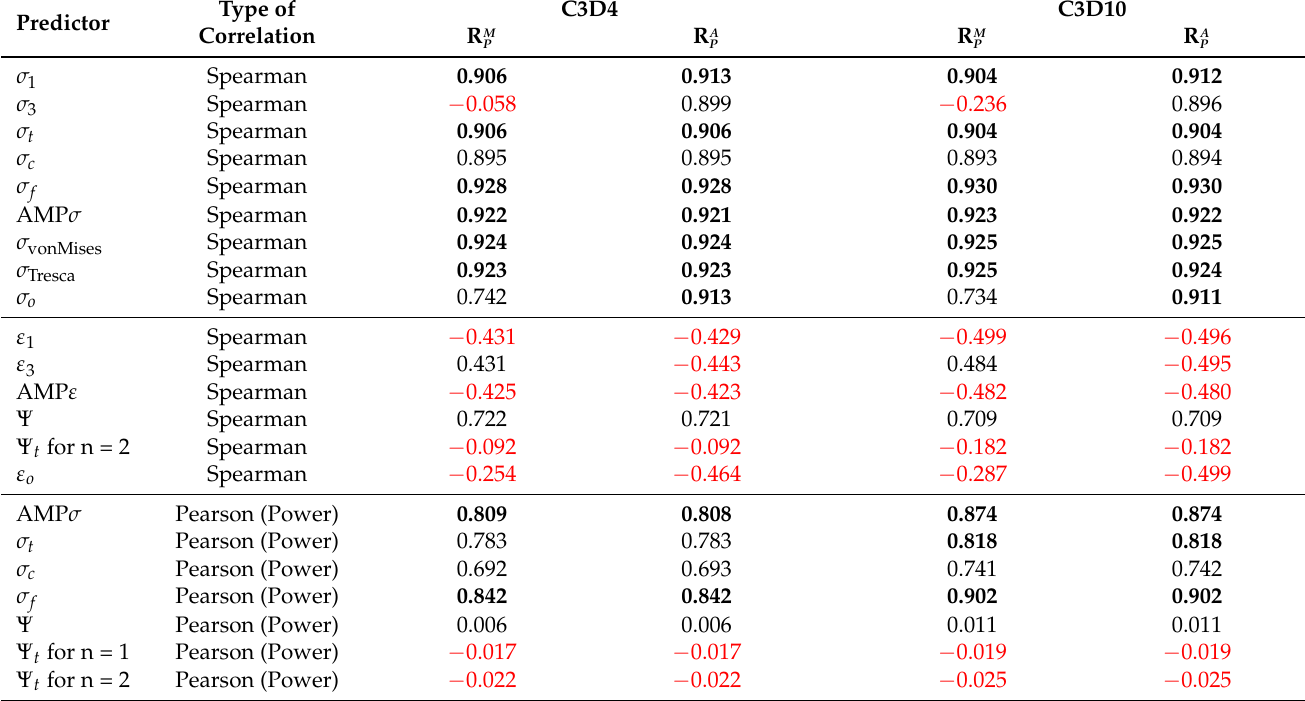
Table 6. Influence of the FE mesh (C3D4 vs. C3D10) on the weighted Spearman and Pearson (power) correlation coefficients obtained for GLT = 80 and constitutive model IsoH : for the maximum variable throughout the cycle, R M , and for the amplitude throughout the cycle, R A . The same P P predictors analysed for Spearman and Pearson coefficients are compared here. Values higher than 0.9 (in Spearman) or 0.8 (in Pearson) are highlighted in boldface; negative values are in